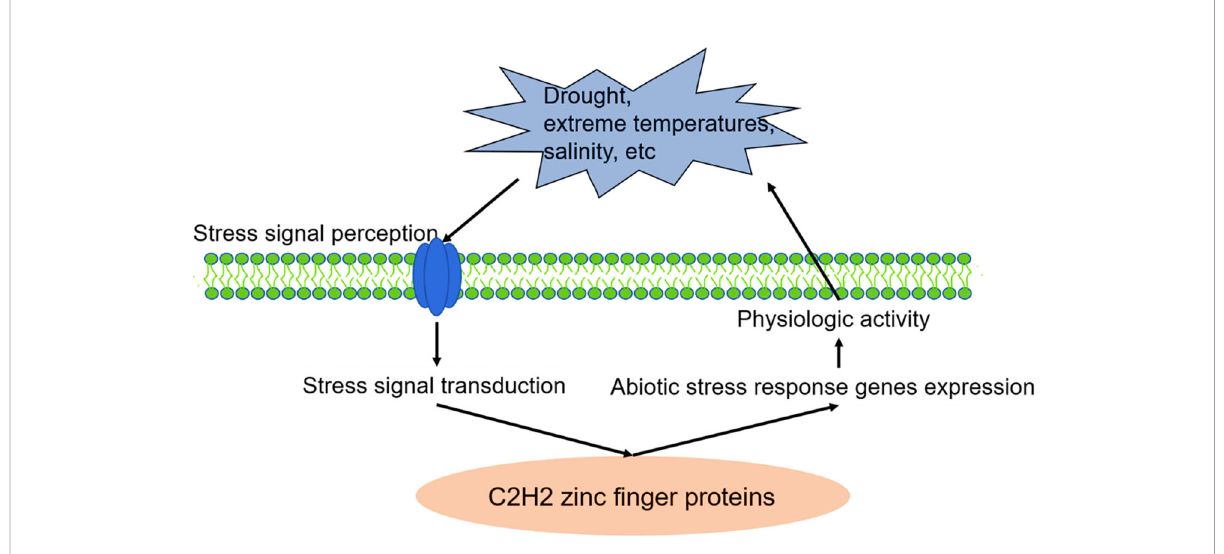
FIGURE 1 C2H2 zinc fi nger proteins are involved in plant stress responses. Source: (Liu et al.,